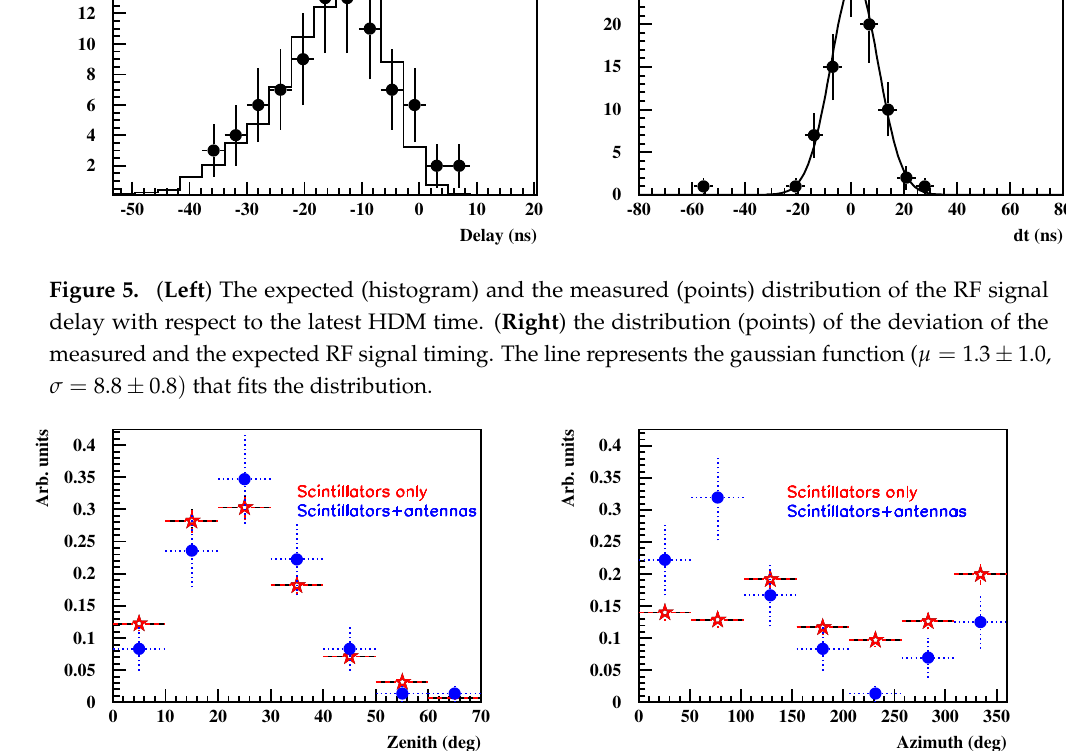
Figure 6. The zenith ( left ) and the azimuth ( right ) distribution of reconstructed showers with sToT value grater that 500ns. The red stars represent the data distributions of reconstructed showers using only the scintillator information, while the blue points represent the data distributions of reconstructed showers with identified RF